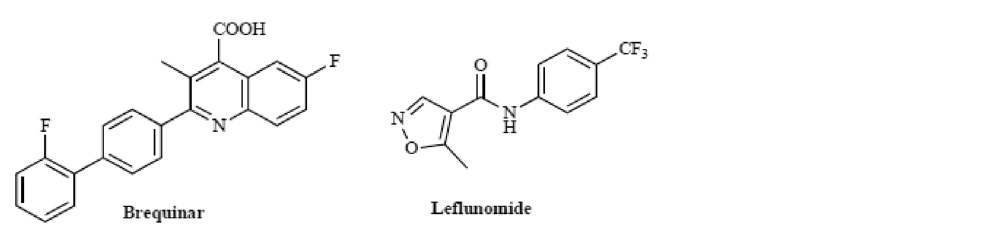
Figure 2. DHODH standard